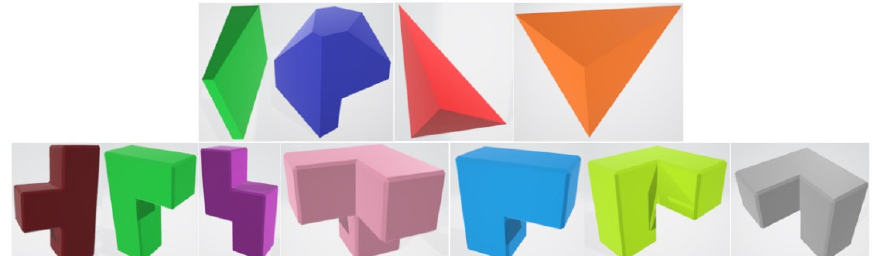
Fig. 12. Non-Convex Pieces (1 to 11 from left to right, from top to bottom) of the data set AÖAB19 from Araújo et al. (2020)